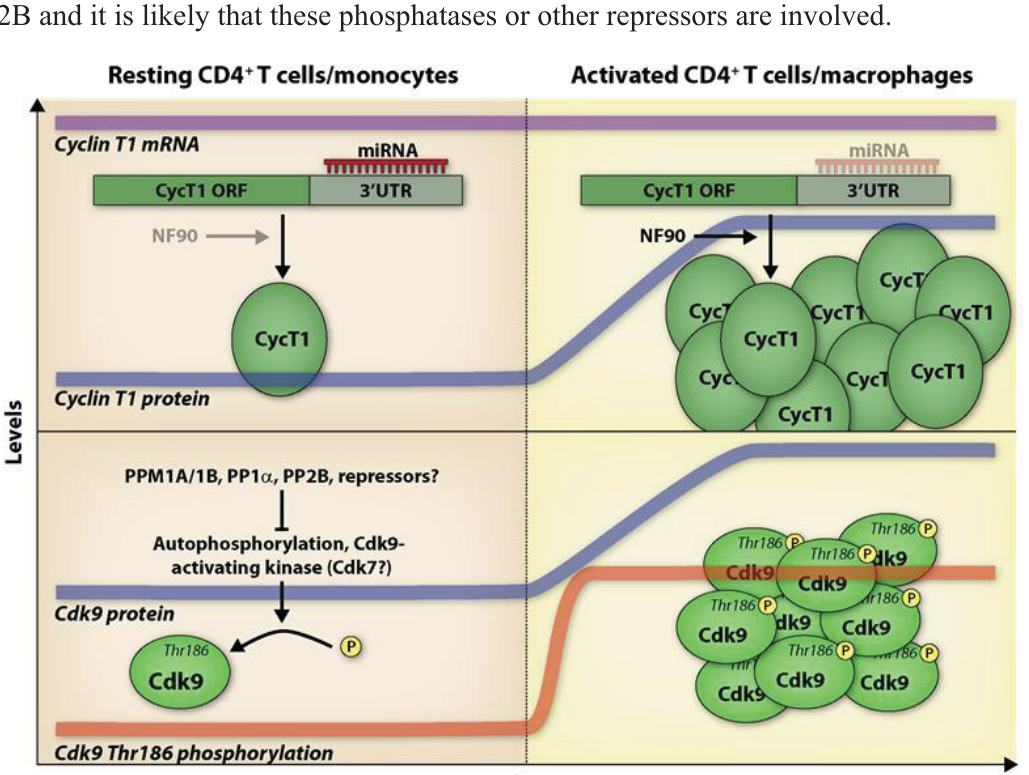
Figure 1. Proposed model for P-TEFb regulation in resting CD4+ T cells/monocytes